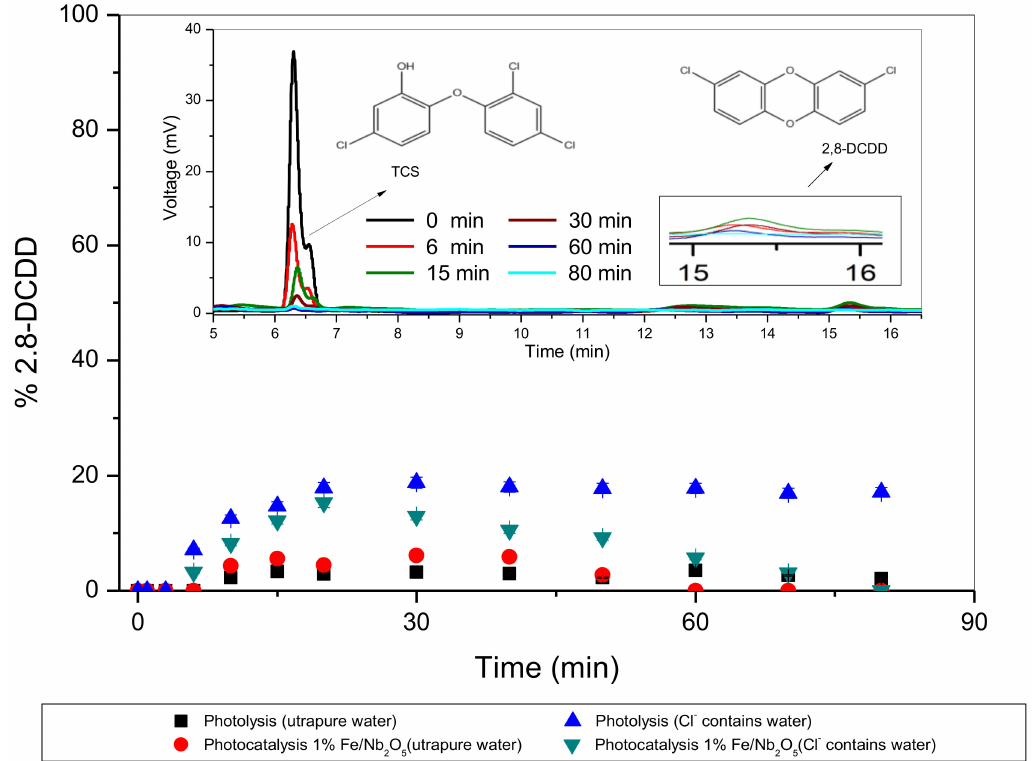
Figure 7. Generation of 2.8-DCDD from photocatalytic and photolytic processes in different